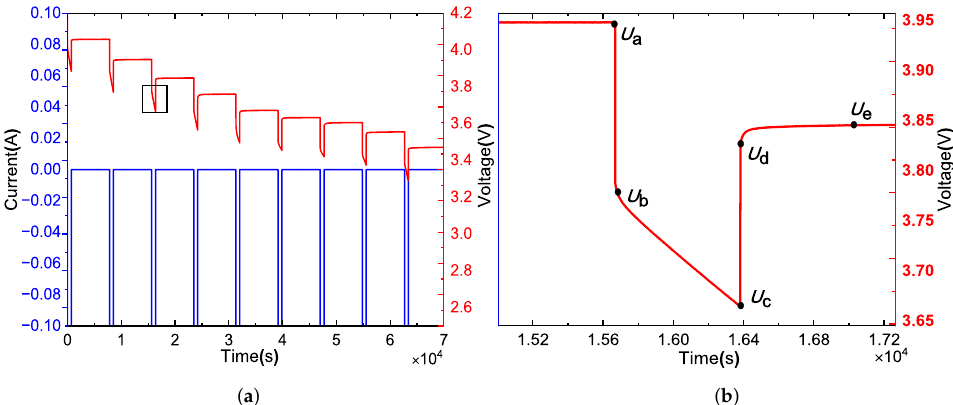
Figure 2. Discharge data and voltage amplification curve: ( a ) Discharge pulse voltage and current, ( b ) voltage